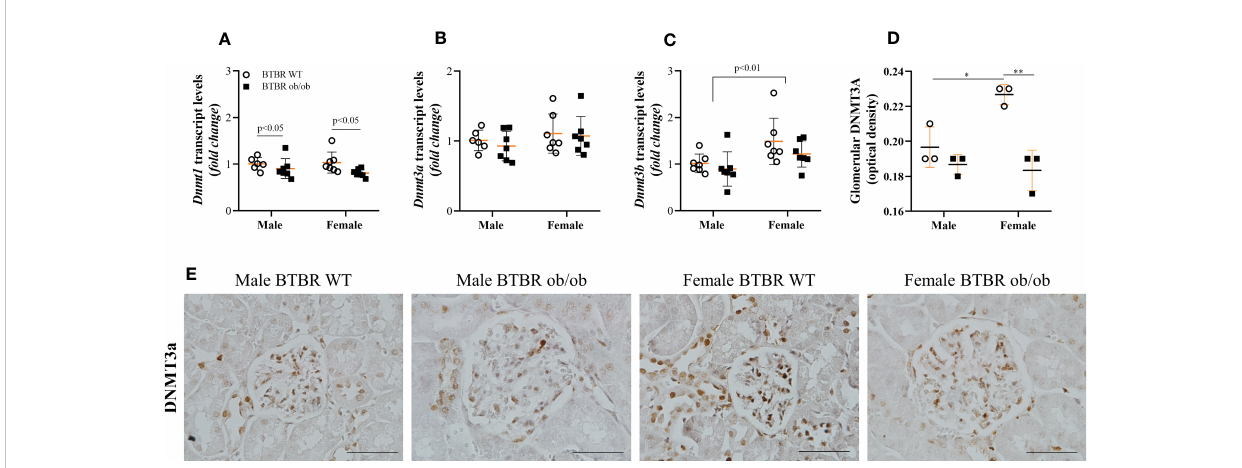
FIGURE 4 Female BTBR ob/ob mice exhibit decreased glomerular expression of epigenetic enzyme DNMT3A. Effects of sex and metabolic condition in BTBR mice on Dnmt1 (A) , Dnmt3a (B) , and Dnmt3b (C) transcripts levels and on total glomerular expression of DNMT3a (D, E) . The values are the mean±SD (n=3 - 7). Immunohistochemistry images were captured using NIS-Elements software coupled to a light microscope equipped with a 40x objective (Eclipse 80i). Bars = 50 m m. WT, wild type; Dnmt1 , DNA methyltransferase 1; Dnmt3a , DNA methyltransferase 3 alpha; Dnmt3b , DNA methyltransferase 3 beta. p values corresponding to the independent effect of metabolic condition or sex are speci fi ed in the graphs. *p<0.05 versus male BTBR WT; **p<0.05 versus female BTBR